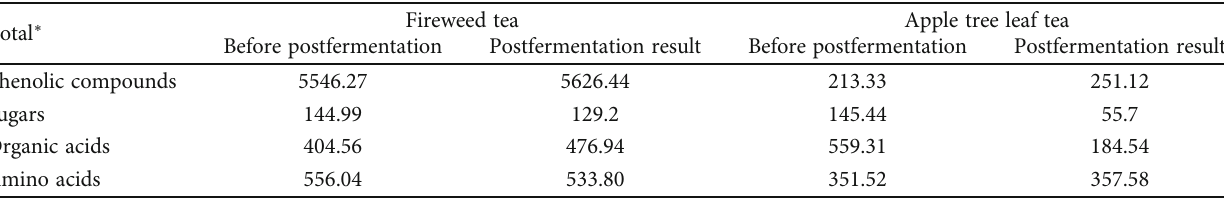
Figure 6: (a) Impact of Eurotium cristatum INA 01267 postfermentation on the composition of amino acids in herbal teas ( μ g/g). Fireweed tea. Presented data of free amino acid content are mean values from 3independent extractions ± standard deviation ð SD Þ . ∗ Essential amino acids. (b) Impact of Eurotium cristatum INA 01267 postfermentation on the composition of amino acids in herbal teas ( μ g/g). Apple tree leaf tea. Presented data of free amino acid content are mean values from 3 independentextractions ± standard deviation ð SD Þ . ∗ Essential amino acids. Table 3: Impact of Eurotium cristatum INA 01267 postfermentation on the composition of biologically active compounds from four di ff erent groups ( μ